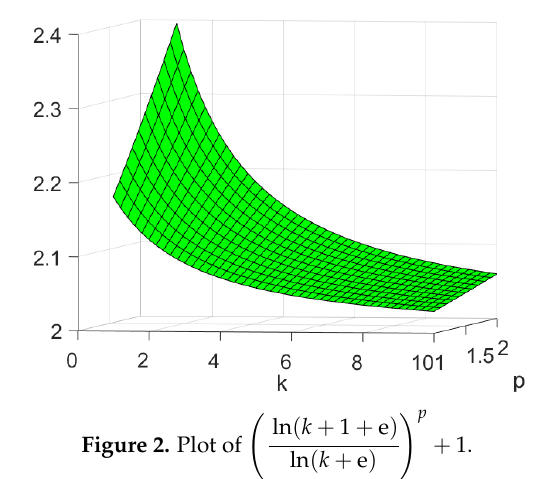
ln ( k + 1 + e ) ln ( k + e ) (cid:33) (cid:32)